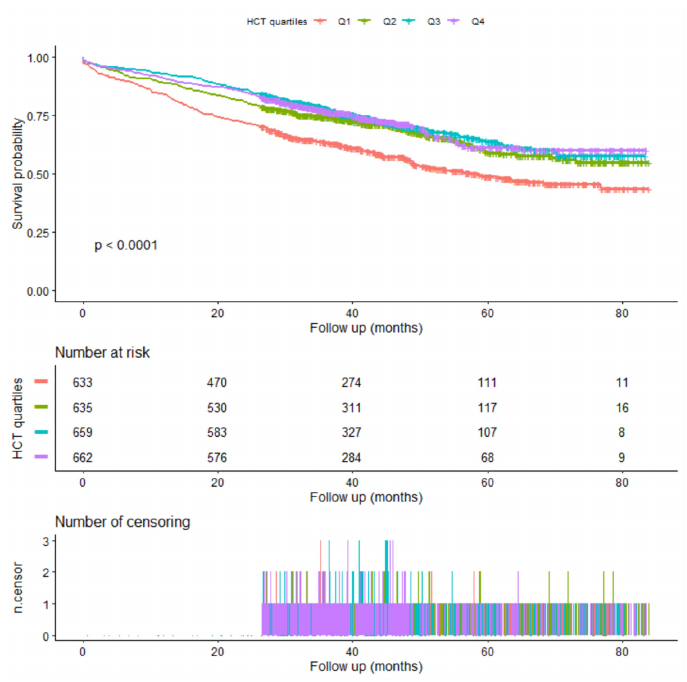
Data in table: HR (95% CI) p -value. Outcome variable: mortality. Exposed variables: HCT. Adjust variables in PSM-adjusted model: age, aCCI. PSM, Propensity Score Matching. The Kaplan–Meier survival curve is shown in Figure 2.